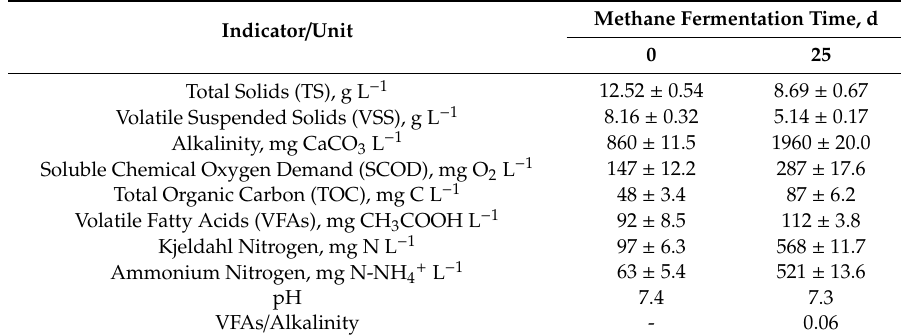
Table 3. Changes of physico-chemical parameters of excess sludge in a 25-day methane fermentation process.